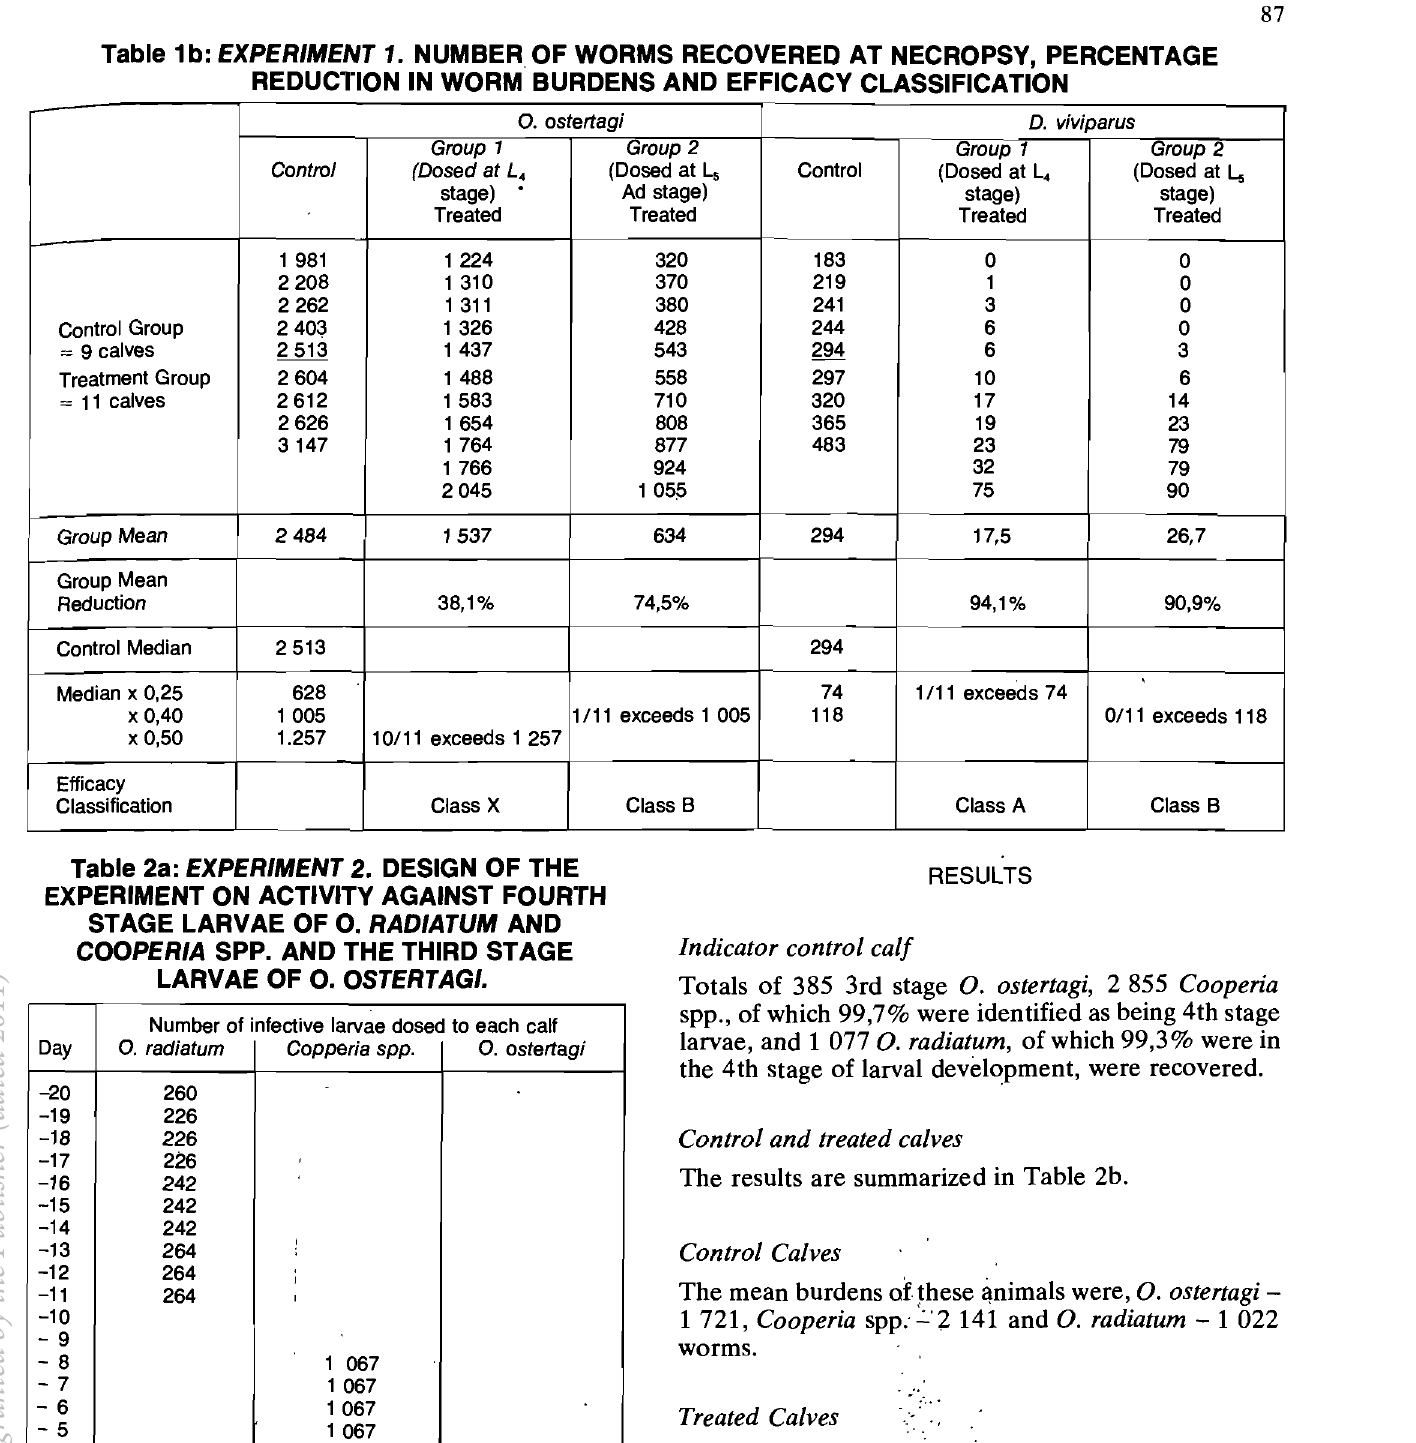
Table 1 b: EXPERIMENT 1. NUMBER. OF WORMS RECOVERED AT NECROPSY, PERCENTAGE REDUC1·ION IN WORM BURDENS AND EFFICACY CLASSIFICATION